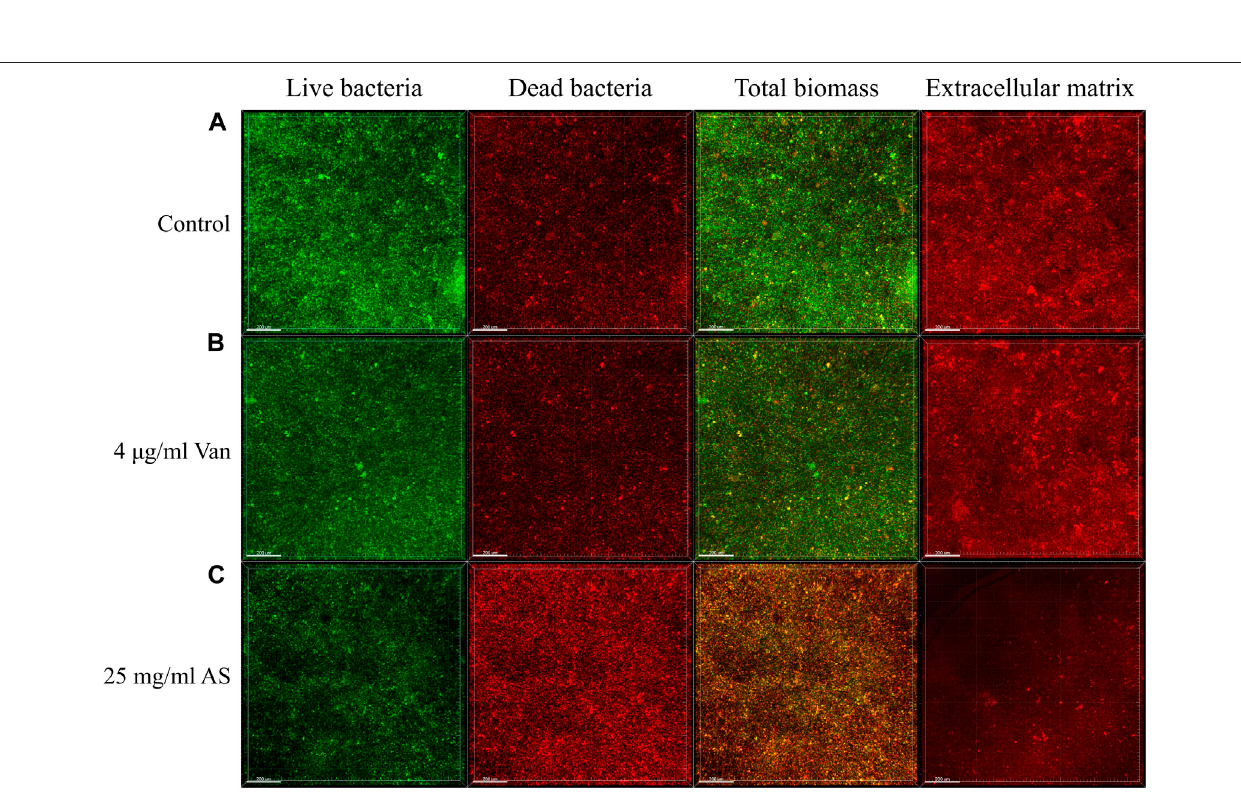
FIGURE 1 | Detection of the MIC of each drug for MRSA bio fi lms. (A) The MICs of Van and AS for MRSA. (B) Effects of different concentrations of AS on living bacteria in MRSA bio fi lms (** p < 0.01, compared with the control).